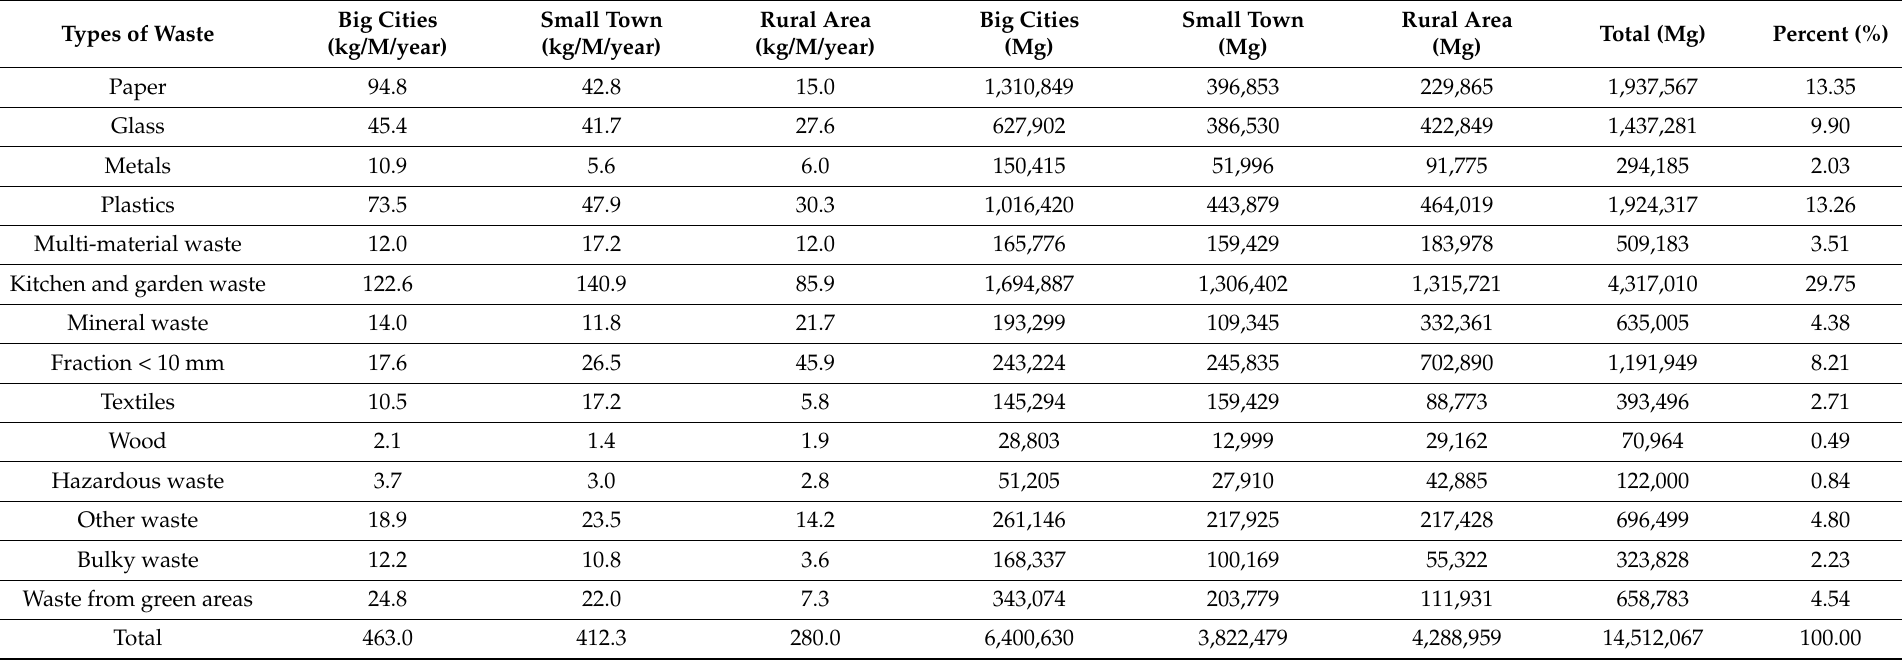
Table 6. Calculation of the mass of individual fractions of municipal waste generated in Poland (calculations for